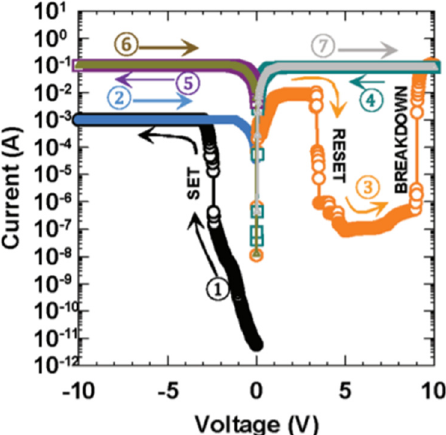
Figure 5: A typical current – voltage ( I – V ) resistive switching char - acteristics ( steps ➀ – ➂ before BREAKDOWN ) of an Aloe polysac - charides - based RRAM initiated with a negative voltage sweep with the sweeping direction and sequences indicated by arrows and numbers [ 18 ] .